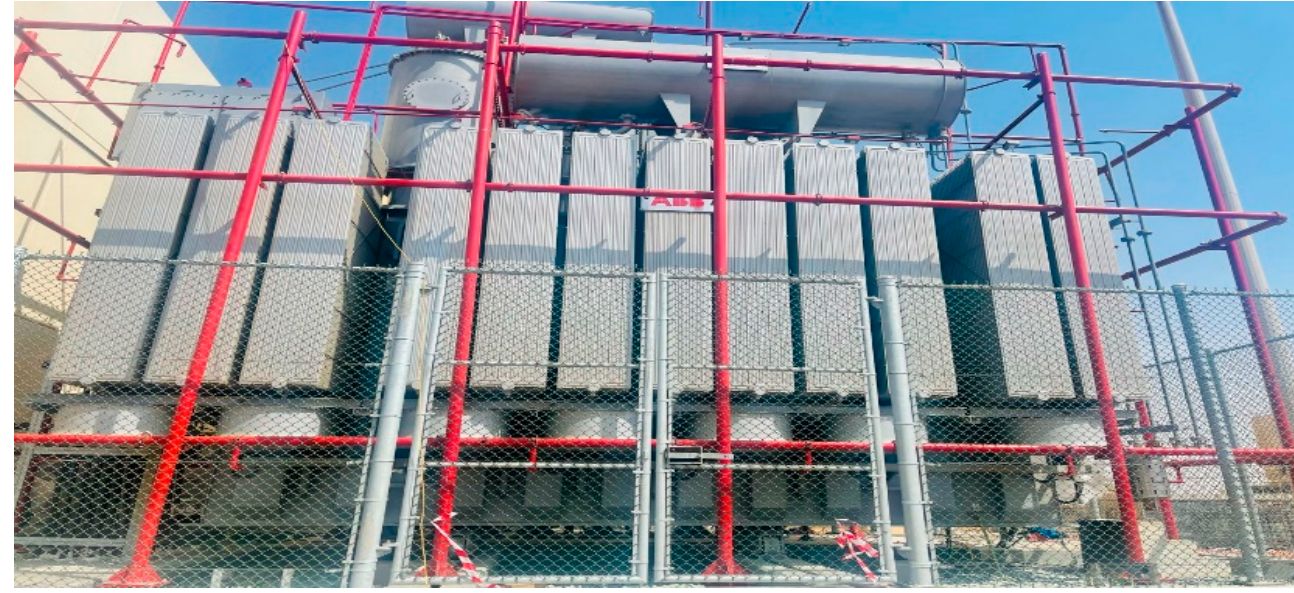
Figure 12. Site pictures taken during the case study.